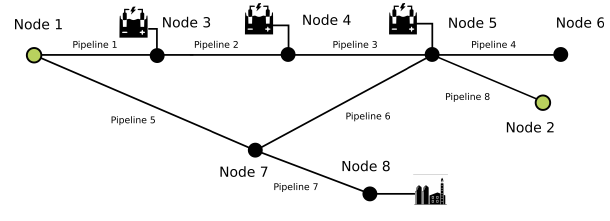
Figure 6. Artificial gas